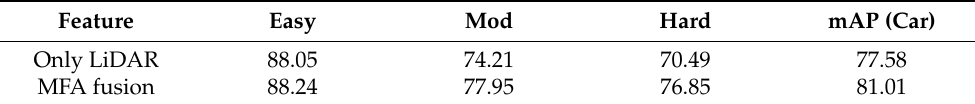
Figure 14. Visualization of MFA. Green/blue/yellow boxes indicate Car/Pedestrian/Cyclist.